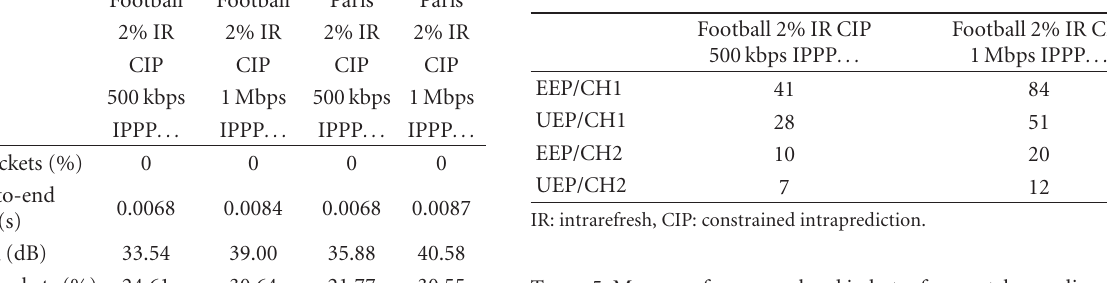
Table 5: Mean per frame overhead in bytes from rateless coding for the Paris